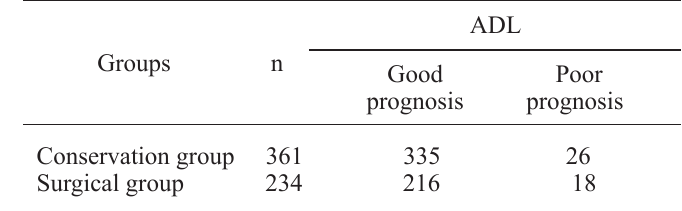
TABLE 2 - Conservative group vs. surgical groups.